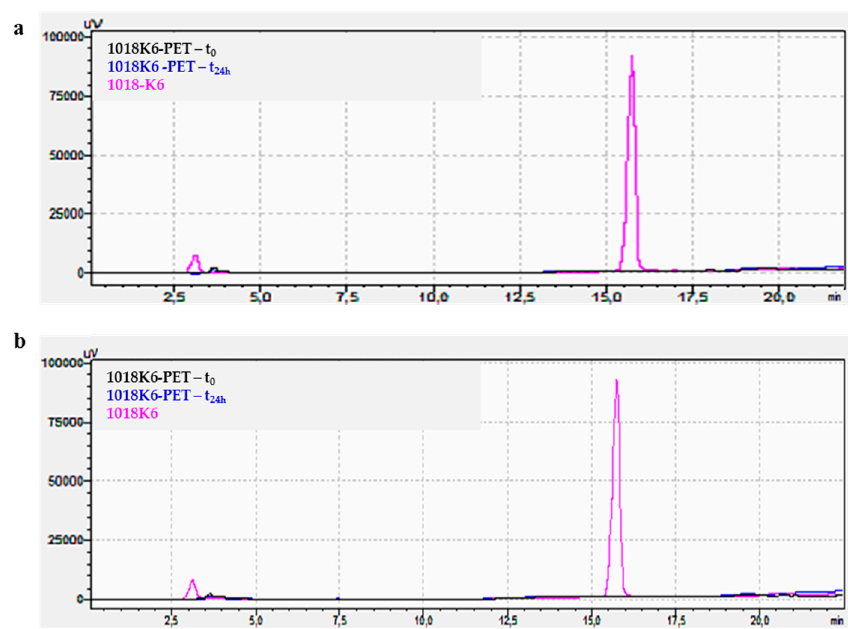
Figure 6. Release analysis of 1018K6 from functionalized PET performed by reverse-phase HPLC chromatography on a C18 column after 24 h incubation at 4 °C in mozzarella brine ( a ) or pure water ( b ). After incubation, the solutions were recovered and injected on C18. The solution in contact with 1018K6-PET at time 0 ( t = 0) and 1018K6 peptide (50 µM) were used as controls.